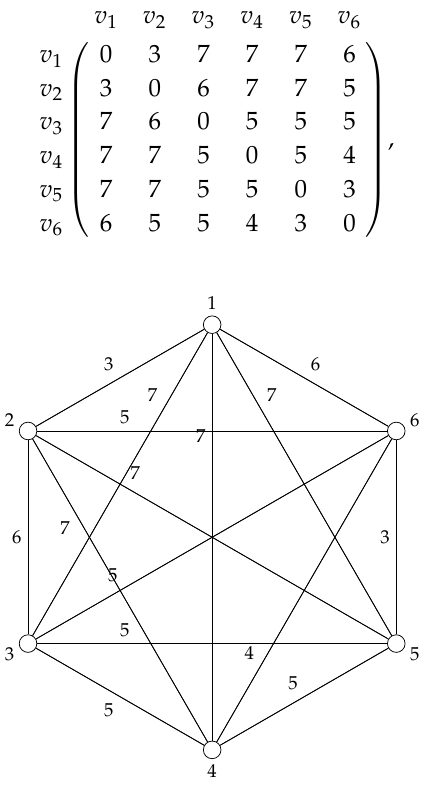
Figure 2. The graph that corresponds to the first six voting records in the 1984 US Congress